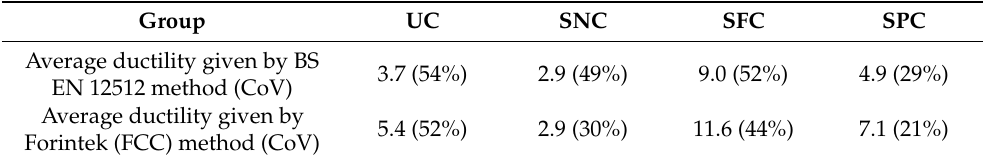
Table 9. Average ductility of each group in connection test. Group UC SNC